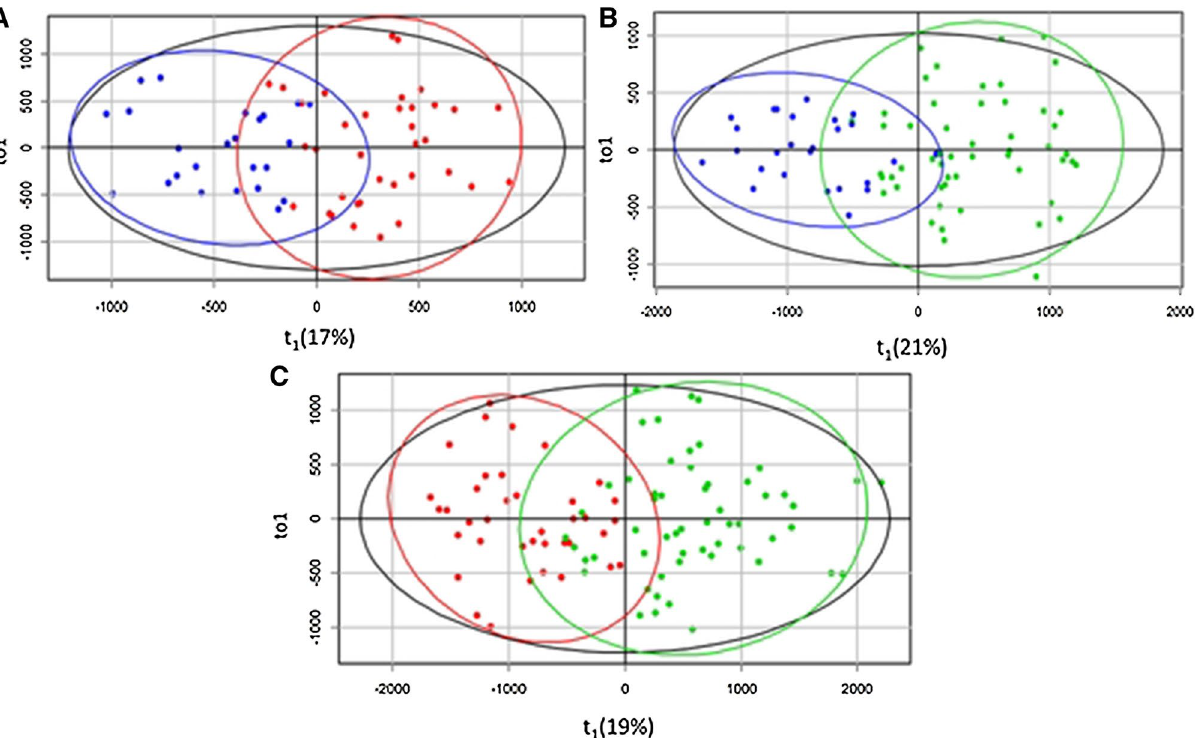
Figure 3. OPLS-DA score plots of plasma lipidomic data (blue dots correspond to control group, red dots correspond to the UF group, and green dots correspond to RUF): ( A ) Control group vs. first-time diagnosed UF. ( B ) Control group vs. RUF. ( C ) First-time diagnosed UF vs.